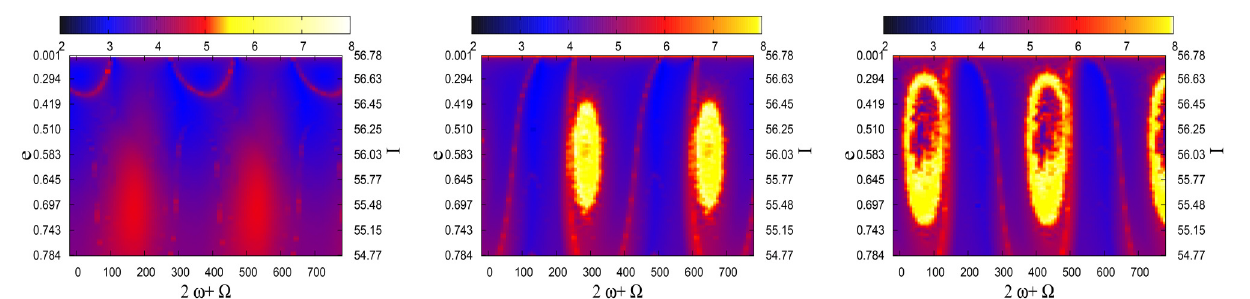
FIGURE 5 | FLIs for the model b, for a = 29 , 546 km, T = 0.04 and: (cid:127) = 0 ◦ (left); (cid:127) = 90 ◦ (middle); (cid:127) = 270 ◦ (right).